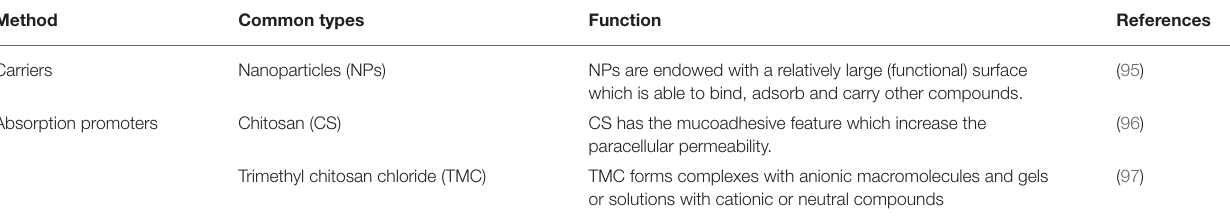
TABLE 5 | Methods for improving the bioavailability of